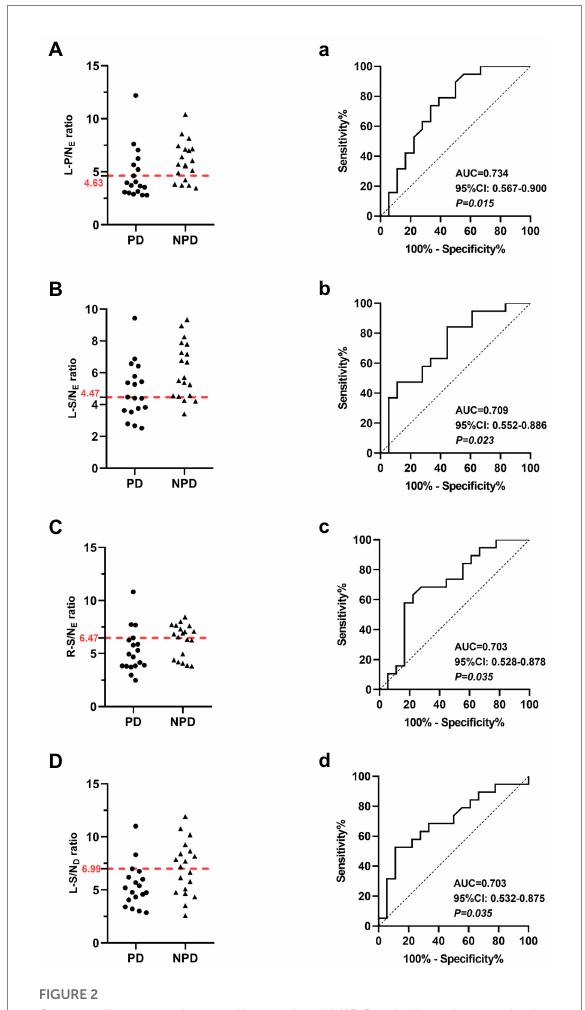
FIGURE 2 Scatter diagrams show salivary gland MIBG scintigraphy results in the differentiation of PD and NPD. (A) The left parotid gland uptake ratio in early images. (B) The left submandibular gland uptake ratio in early images. (C) The right submandibular gland uptake ratio in early images. (D) The left submandibular gland uptake ratio in delayed images. The red dotted line indicates a cutoff value that yields the most appropriate sensitivity and specificity. Receiver Operating Characteristic (ROC) analysis showing sensitivity and specificity of the left parotid gland uptake ratio (a) the left submandibular gland uptake ratio (b) the right submandibular gland uptake ratio (c) in early images, and the left submandibular gland uptake ratio in delayed images (d) used to differentiate patients between PD and NPD.